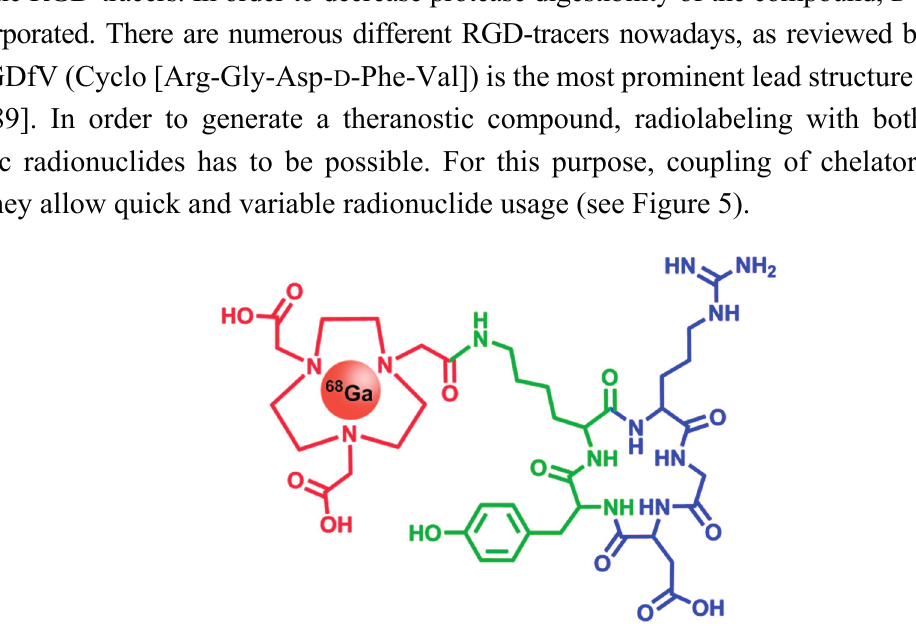
Figure 5. Chemical structure of [ 68 Ga]-NOTA-c(RGDyK) (NOTA-Cyclo [Arg-Gly-Asp- D - Tyr-Lys]), which is used for the molecular imaging of α v β 3 integrin overexpressing